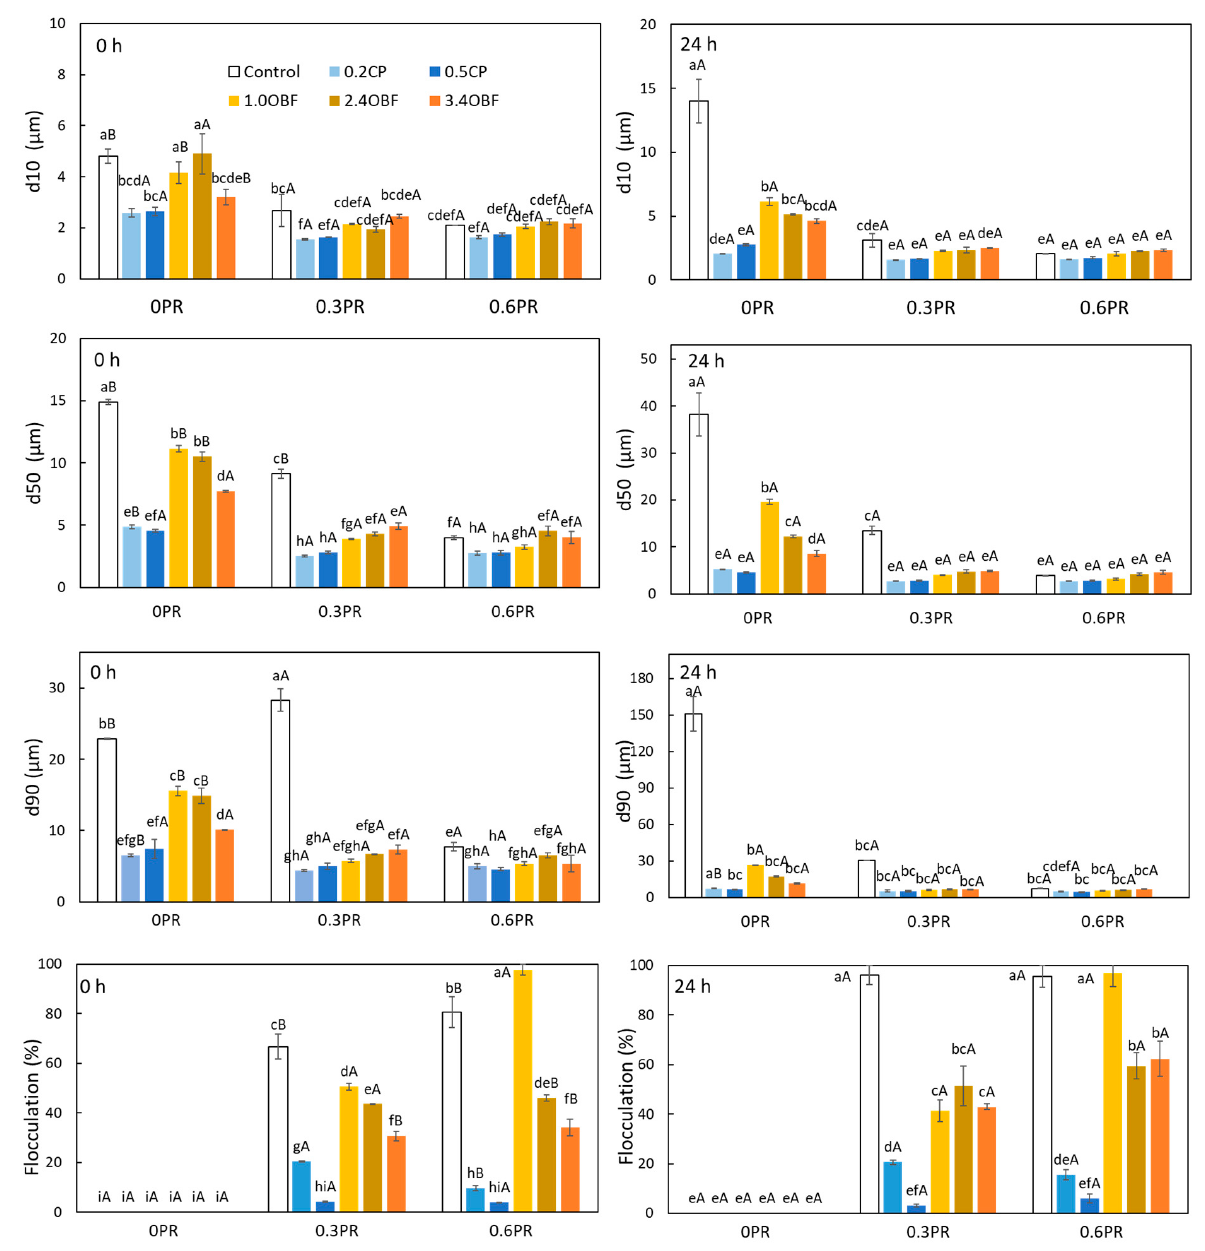
Figure 3. Percentiles of the droplet size distribution and percentage of flocculation of emulsions obtained immediately after their preparation (0 h, left ) and after 24 h ( right ), without any source of pectins or proteins (control), containing purified commercial pectins (0.2CP and 0.5CP for 0.2 and 0.5% w / w , respectively) or an orange by-product flour (1.0OBF, 2.4OBF, and 3.4OBF for 0.95, 2.38, and 3.40% w / w , respectively) combined with proteins (0.3PR and 0.6PR for 0.3 and 0.6% w / w , respectively) or without them (0PR). Different lowercase letters indicate significant ( p < 0.05) differences among samples with different composition, and different uppercase letter means significant differences ( p < 0.05) between the same sample at 0 and 24 h.